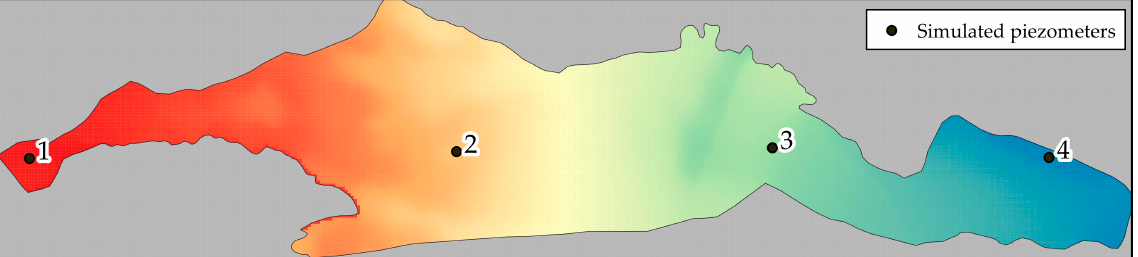
Figure 8. Aquifer scheme with the location of the four points selected to analyze the piezometric heads variation through and between the considered scenarios. The color gradient displays the water table elevation on 26 January 2010, being the highest altitudes in the western sector of the aquifer (on the image: red, at left).